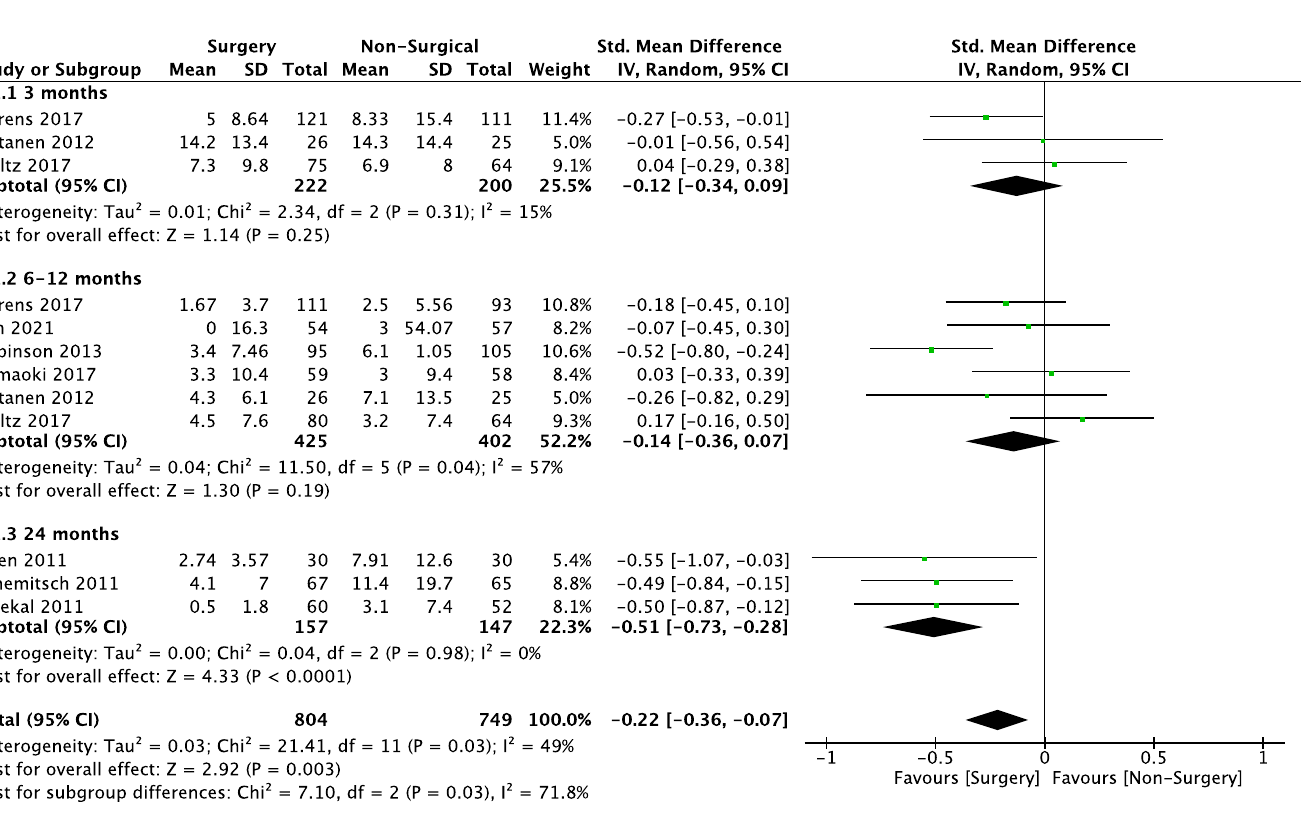
Fig 2. Meta-analysis of overall DASH score at � 3 months, 6–12 months and � 24 months between surgical interventions and non-surgical interventions in the pooled studies. Standard-mean difference is -0.22 (95% CI -0.36 to -0.07; p = 0.003).